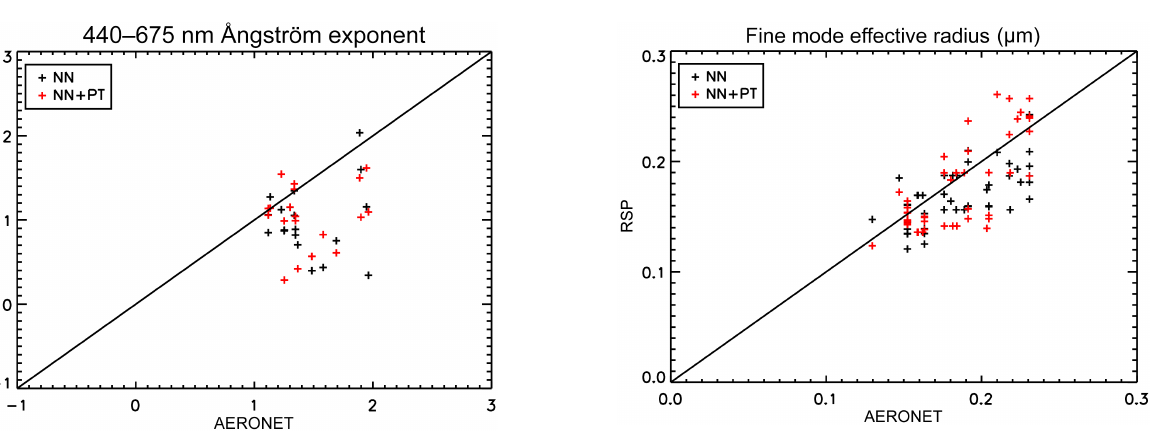
Figure 13. RSP versus AERONET 440–675nm Ångström ex- ponent. Black crosses: neural network retrievals. Red crosses: Phillips–Tikhonov with neural network first guess. Statistics shown in Table 6.